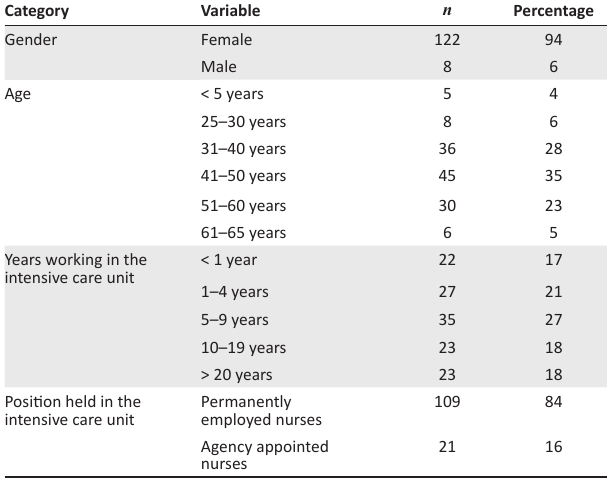
TABLE 3: Demographic profile of the sample